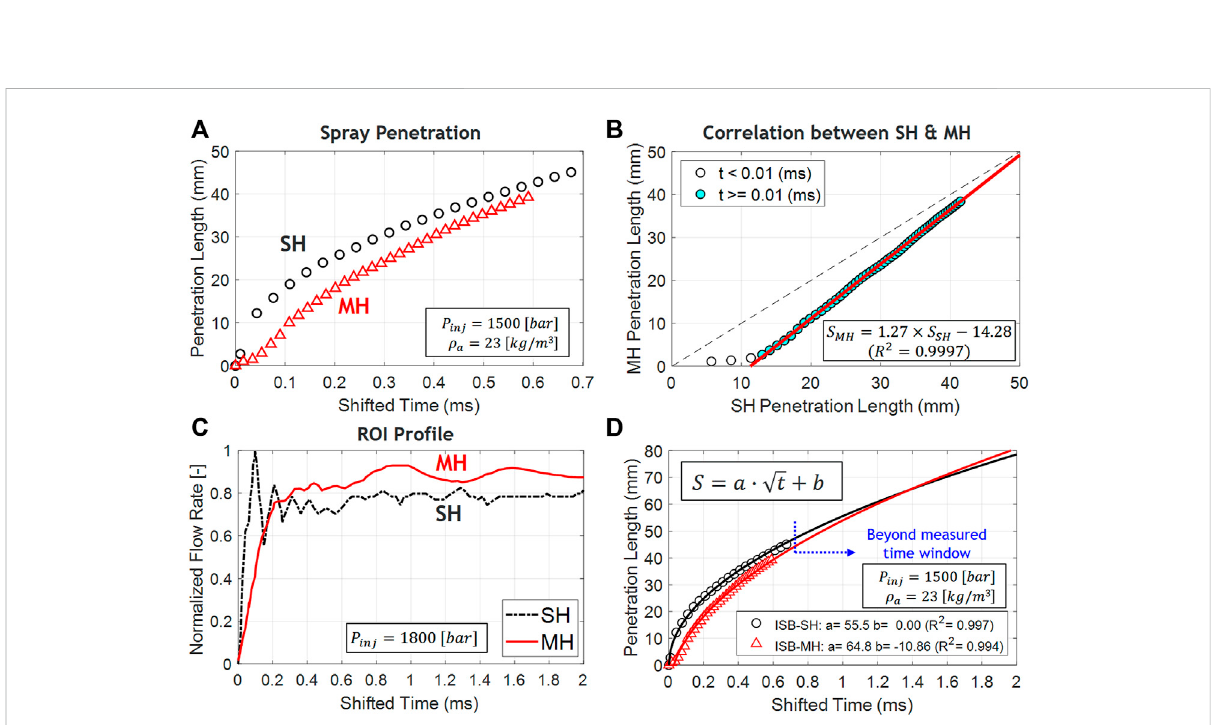
FIGURE 8 (A) Comparison of spray penetration between medium-duty SH (black) and MH (red) injectors. (B) Scatter plot of the penetration length of the SH and MH injectors with a linear correlation curve. (C) Normalized rate-of-injection (ROI) pro fi les using the SH and MH injectors at an injection pressure of 1,800 bar. (D) Spray penetration correlation obtained for the SH and MH